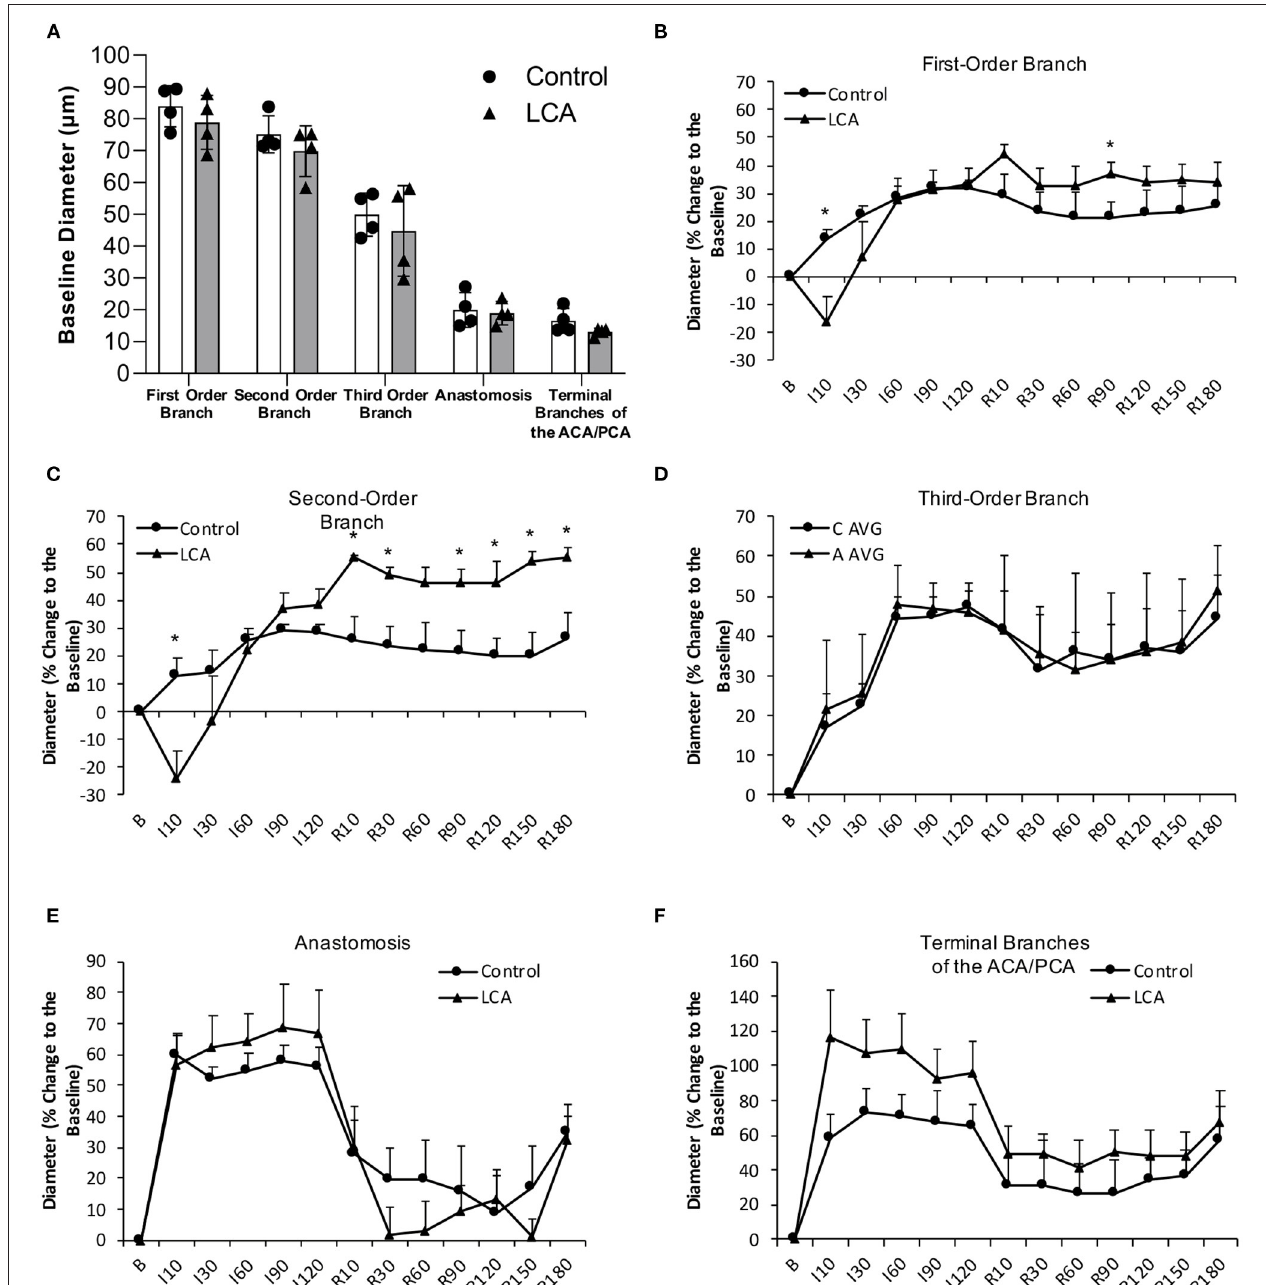
FIGURE 5 | Effect of LAC on baseline diameter and vasoreactivity of the MCA, arterial anastomoses, and terminal branches of the ACA/PCA during 2-h MCA ligation and 3-h reperfusion. (A) Baseline diameter. Values are mean ± SD for four mice in each group. Analyzed using one-way ANOVA. (B–D) Vasoreactivity of the MCA.